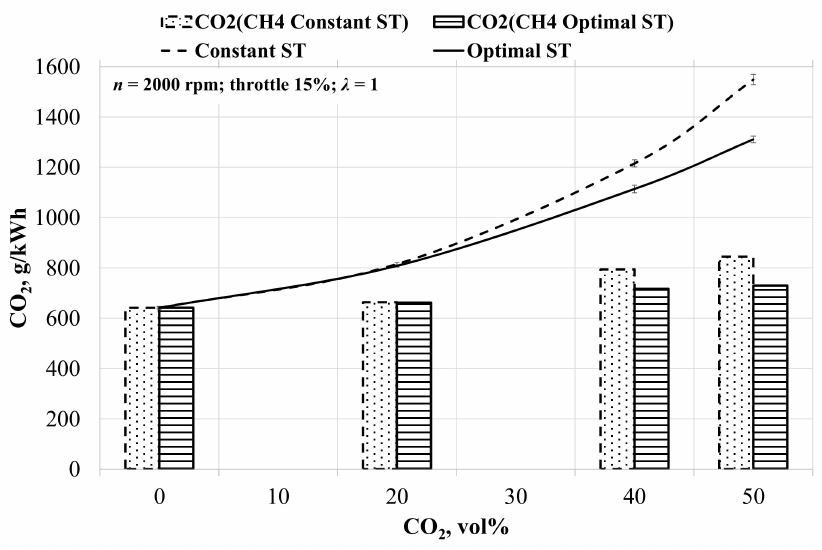
Figure 5. Energy distribution. A—with optimal ST; B—with constant